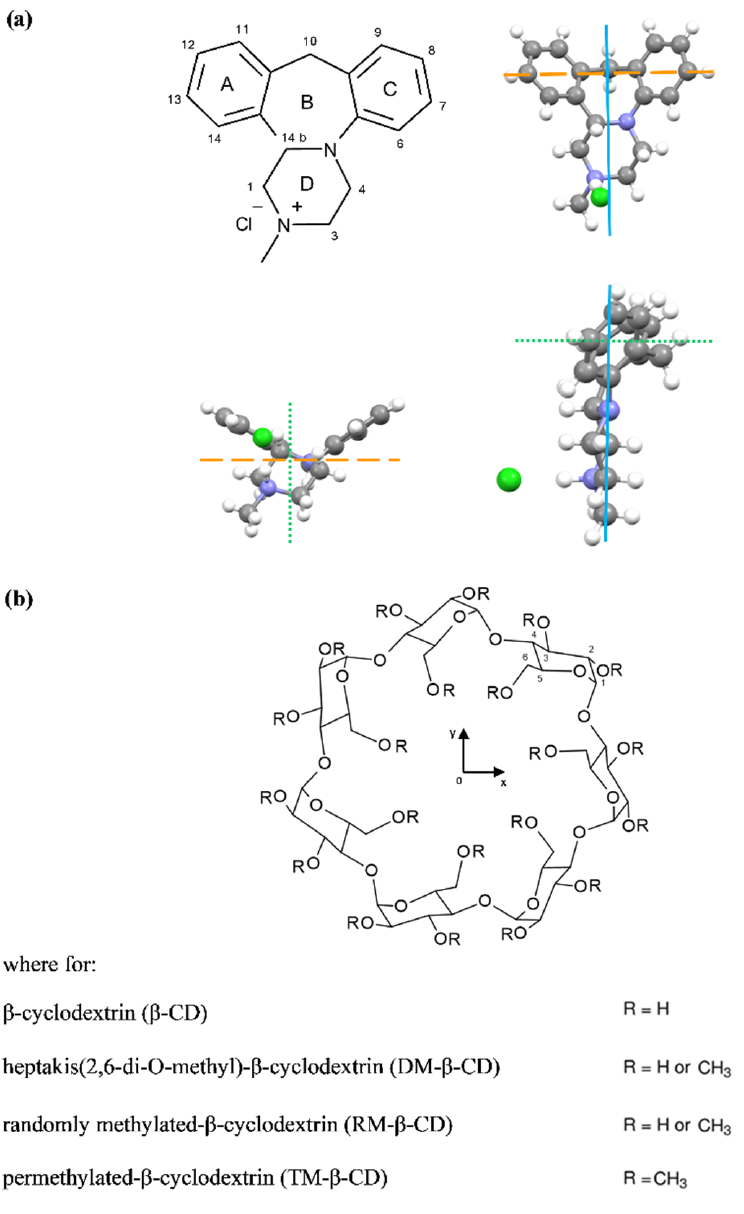
Figure 1. Structures of ( a ) mianserin hydrochloride and ( b ) β -cyclodextrins.